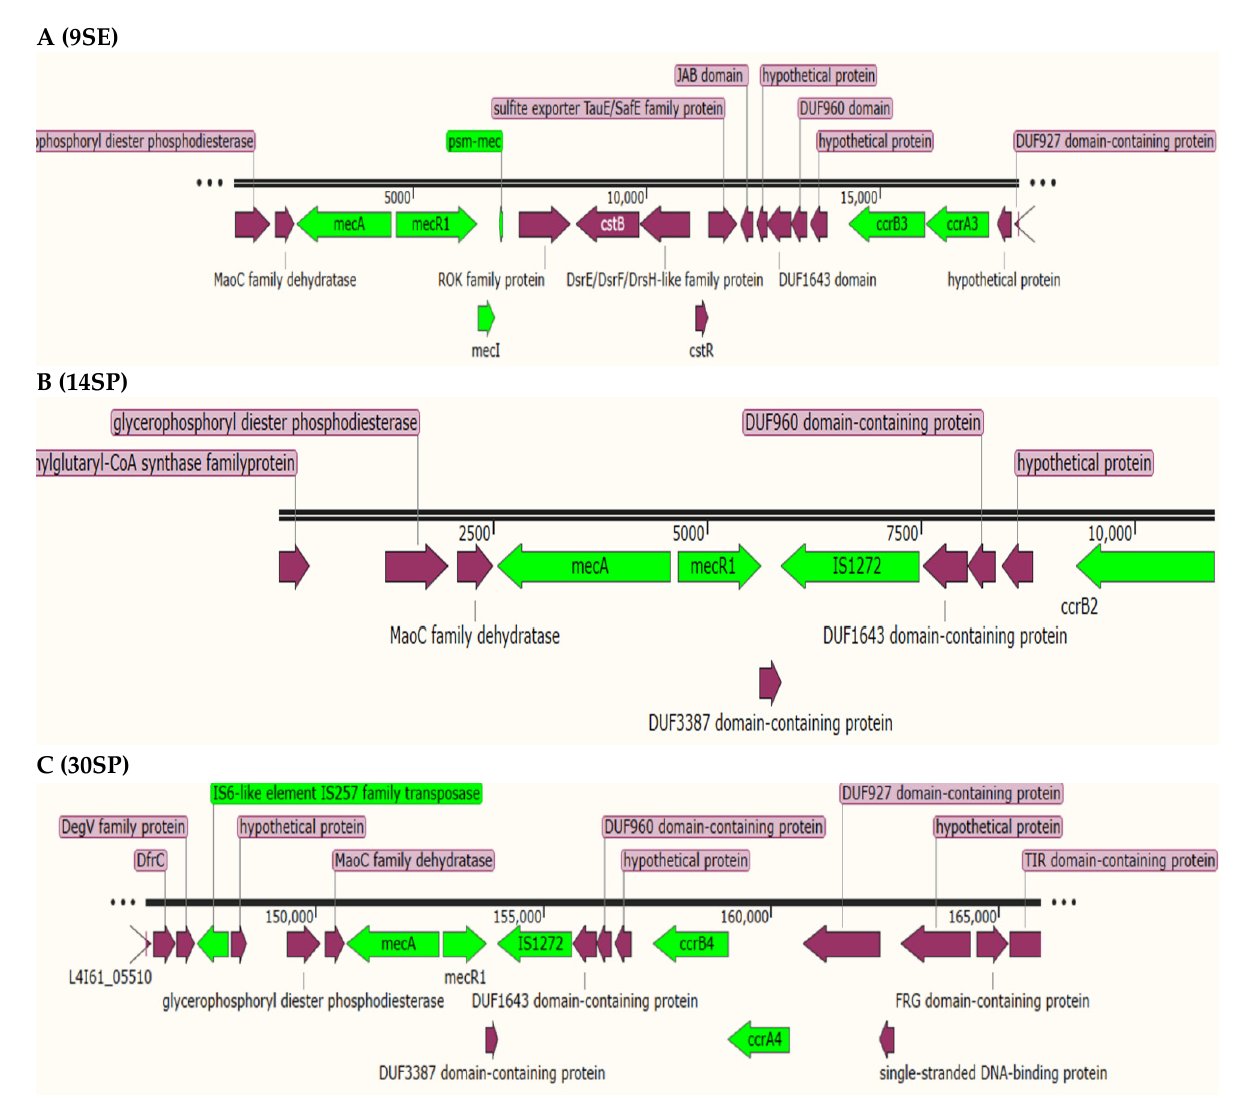
Figure 2. Schematic representation of the unique SCC in the 9SE strain, which contains ccrC2 and IS257, shown in green. The purple arrows showing other genes present in the same contig.